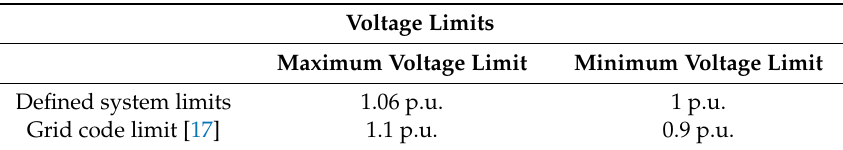
Table 3. The grid code and define limits for the analysis.